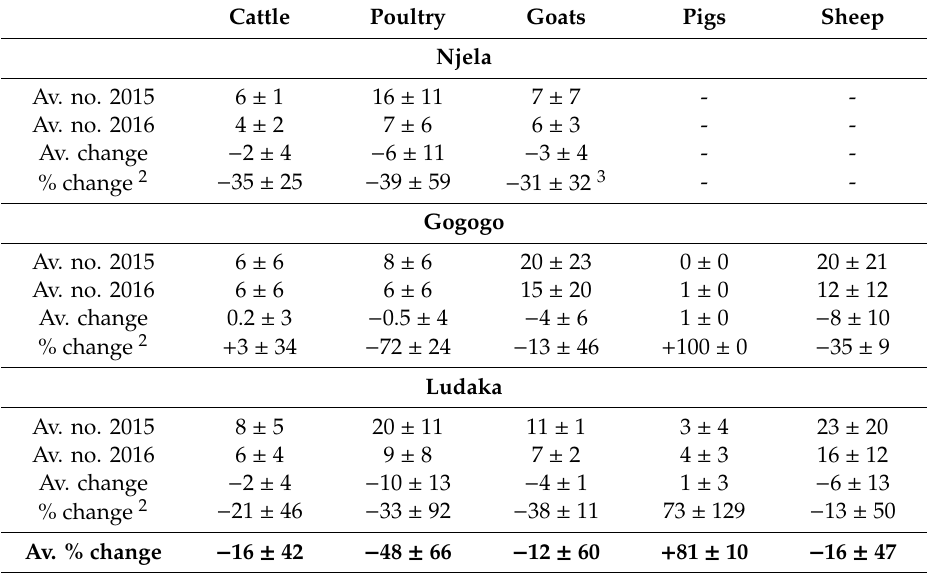
Table 2. Change in the average number of animals per household between 2015 and 2016 1 . Cattle Poultry Goats Pigs Sheep Njela Av. no.